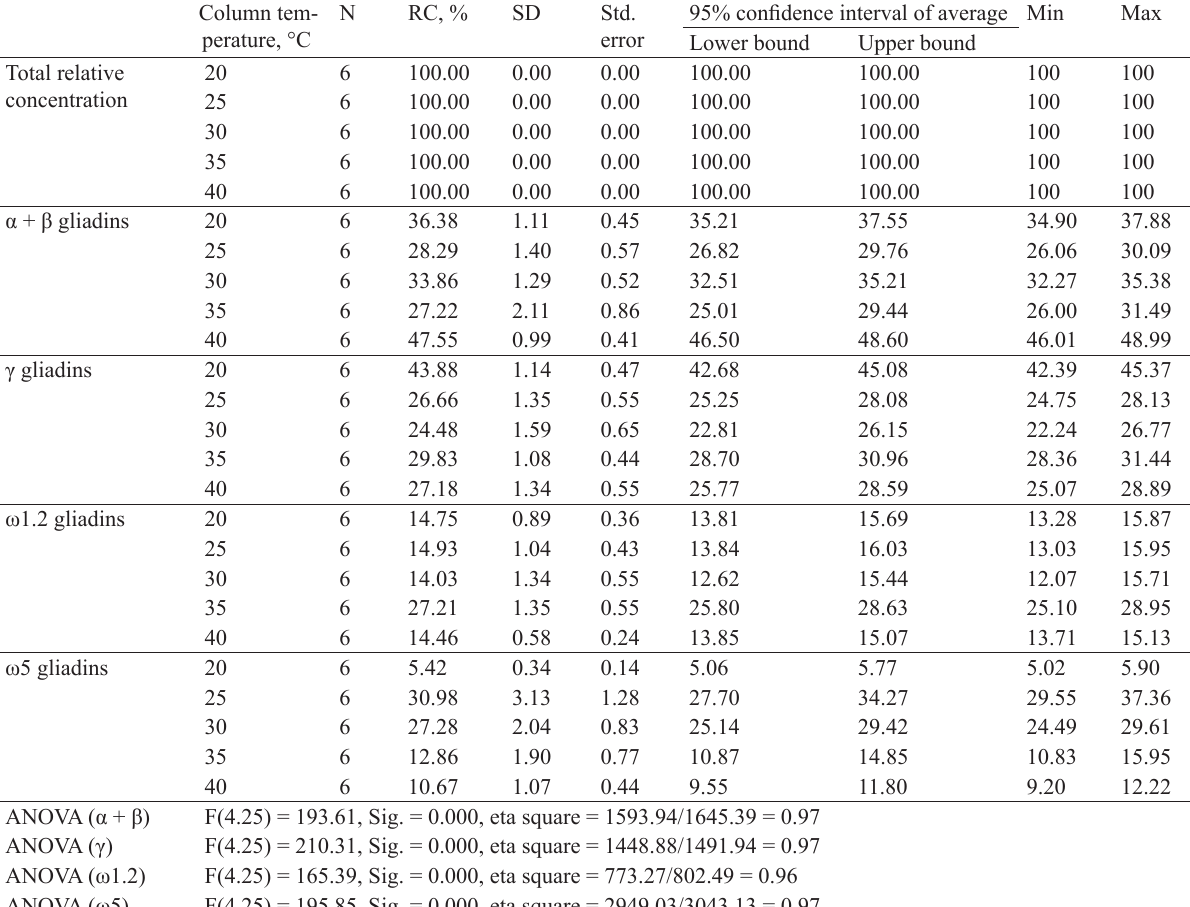
Table 5 Descriptive indicators of the total relative concentration of proteins and relative concentration of gliadin fractions (solvent 70% ethanol, Agilent, CE 7100, capillary inside diameter 50 µm, total capillary length 33 cm, effective capillary length 23.50